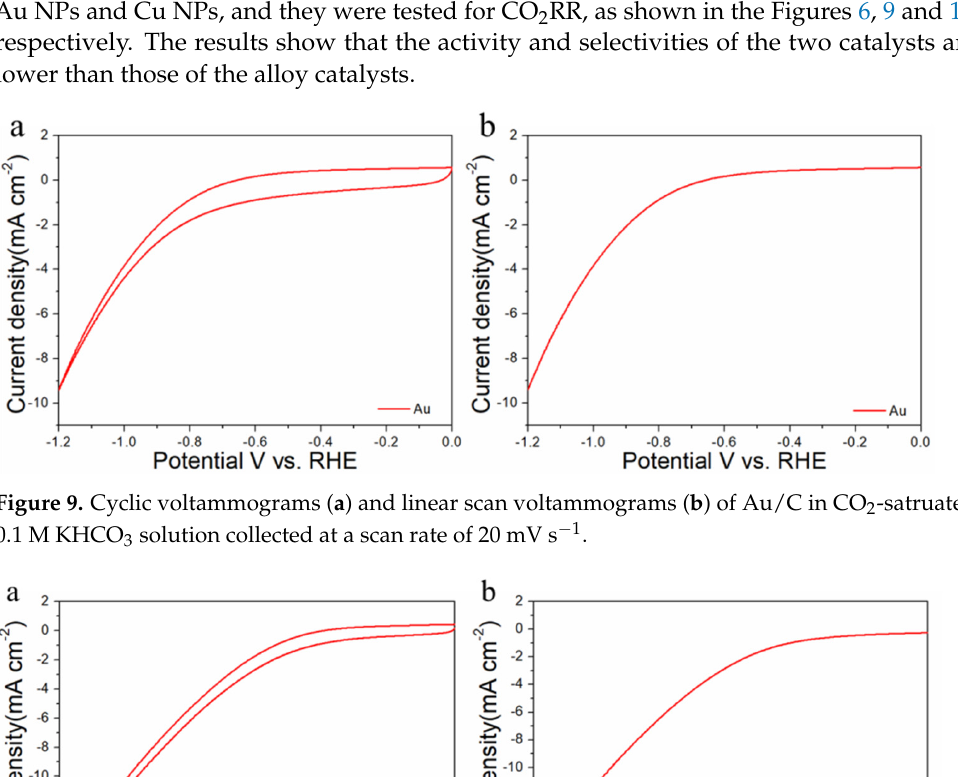
Figure 8. The H 2 FE of Au 25 Cu 75 /C, Au 50 Cu 50 /C and Au 75 Cu 25 /C, Au/C and Cu/C. For comparisons with the pure metal catalysts, we used the same method to synthesize Au NPs and Cu NPs, and they were tested for CO 2 RR, as shown in the Figures 6, 9 and 10, respectively. The results show that the activity and selectivities of the two catalysts are lower than those of the alloy catalysts.